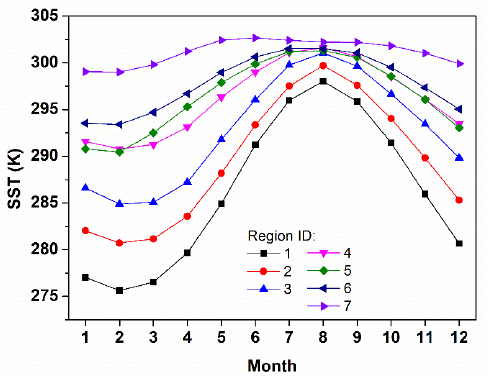
Figure 9. Variation of monthly mean SST for different sea areas around China during 1979–2021.